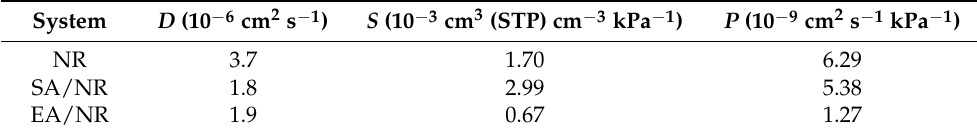
Table 4. The D , S, and P values for O 2 in NR and AO/NR systems at 298K. Table 4. The D , S , and P values for O 2 in NR and AO/NR systems at 298K. System